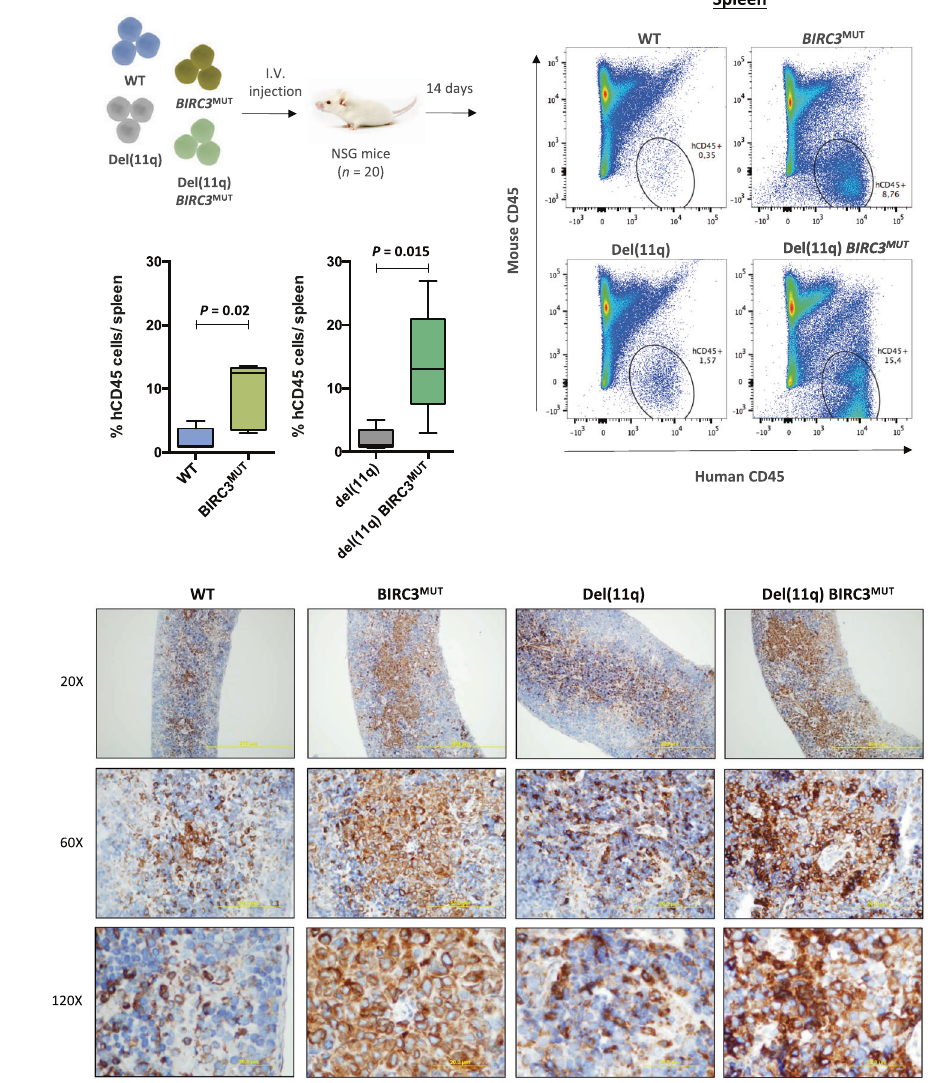
Fig. 6 In vivo analysis of leukemic progression of del(11q)/ BIRC3 -mutated CRISPR/Cas9-edited clones. A Spleen in fi ltration of xenotransplanted HG3 WT , HG3 BIRC3 MUT , HG3-del(11q), and HG3-del(11q) BIRC3 MUT cell lines ( n = 5/per group) into NSG mice. Mice spleens were analyzed by FACS 14 days after cell injection and hCD45 + cells were monitored to evaluate the leukemic in fi ltration in each condition. B Immunohistochemical analysis of NF- κ B2 (p52) expression in spleens of HG3 WT , HG3 BIRC3 MUT , HG3-del(11q), and HG3-del(11q) BIRC3 MUT xenografted